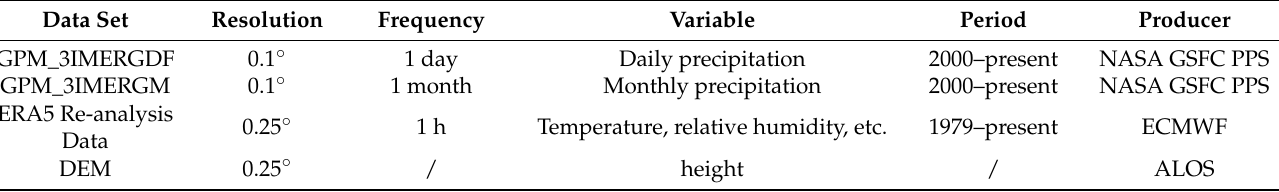
Figure 1. The data used in this article and the data fusion process. H, W represent the size of the data in the vertical and horizontal directions, respectively. Table 1. Summary of the data sets used in this